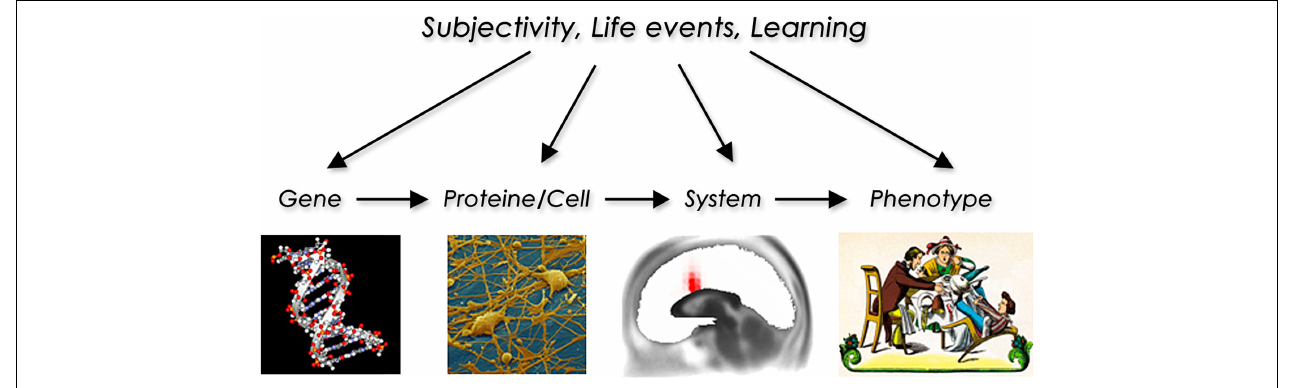
FIGURE 1 | The endophenotype concept illustrated using the example of attention defi cit/hyperactivity disorder showing the way from genetic information to the levels of cell and systems function to a clinical phenotype. Additional infl uences by other factors may occur at every level.